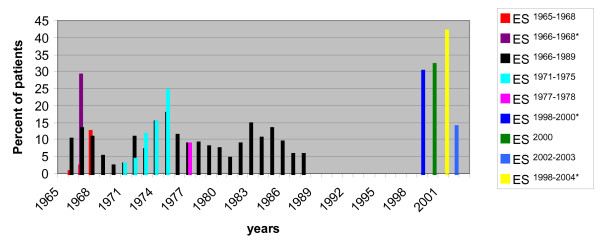
Percentage of pneumococcal meningitis cases based on studies conducted over 39 years. A representation of nine different studies conducted on patients diagnosed with meningitis due to different etiological agents from 1965-2004. In the study ES1965-1968 on 644 cases of ABM 3% (21 patients) of the cases reported were due to pneumococcal infection [5]. ES1966-1968 conducted on 187 meningitis patients S. pneumoniae was responsible for 29% of 123 culture-positive cases [6]. ES1966-1989 conducted on 7,809 meningitis or encephalitis patients, reported that 7.3% of total cases were due to pneumococcal infection [3]. A retrospective review ES1971-1975 of 1,333 patients with ABM, reported 7.9% of meningitis cases diagnosed with pneumococcal meningitis [13]. ES1977-1978 revealed pneumococci was the prevalent bacteria detected [10]. Surveillance of 2047 patients with meningitis in ES1998-2000 was conducted to determine the etiology of the disease in children less than 6 years. 30% of 228 patients of the cases confirmed by culture were positive for S. pneumoniae. However, in children older than 12 months and less than 6 years, S. pneumoniae was the leading causative agent [4]. ES2000revealed that S. pneumoniae compromised 32% of ABM [1]. ES2002-2003 on 310 children clinically diagnosed with meningitis; 202 patients were diagnosed with ABM; 13.9% of total meningitis cases were infected with S. pneumoniae and 21.3% of ABM [21]. ES1998-2004S. pneumoniae was responsible for 42% culture-positive bacterial meningitis cases [2]. The asterisks represent epidemiological studies reporting an average during the entire period of the study.